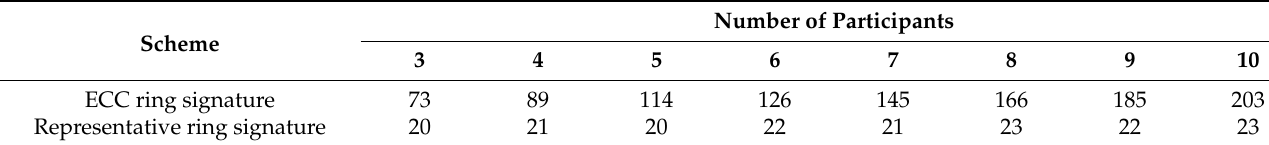
Table 4. A comparison of signature verification time of two schemes (unit: ms).